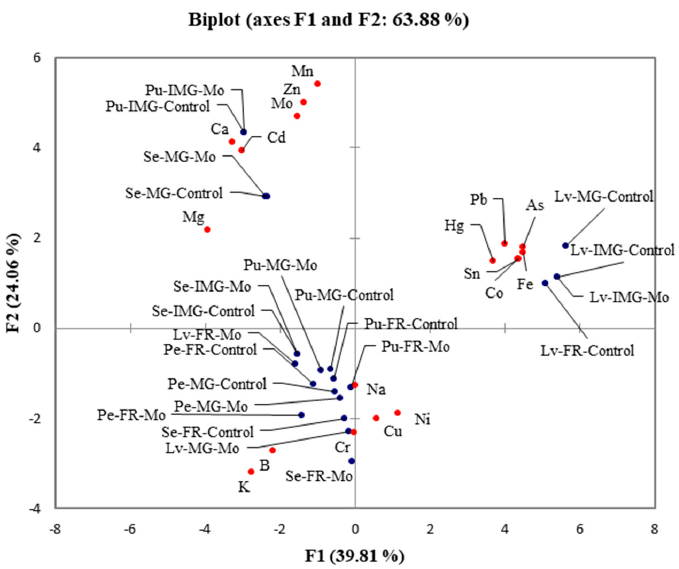
Figure 1. Principle component analysis among Mo application and nutritional concentrations